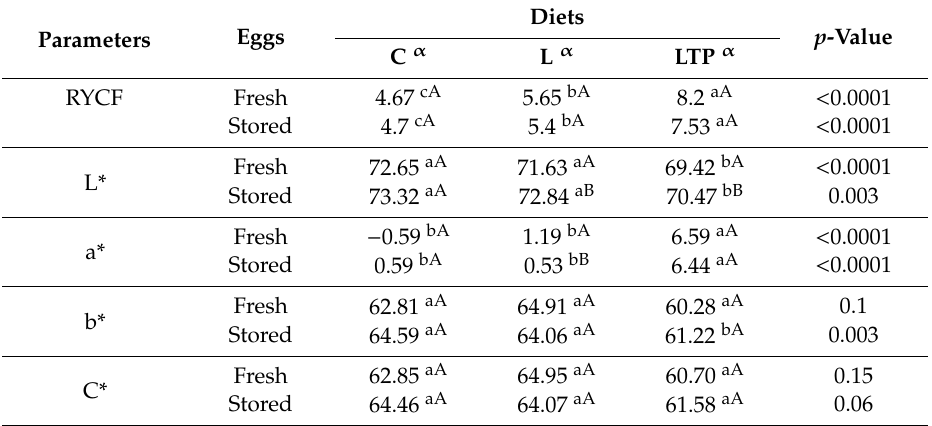
Table 5. Egg yolk coloration before and after storage at 4 ◦ C for one month.